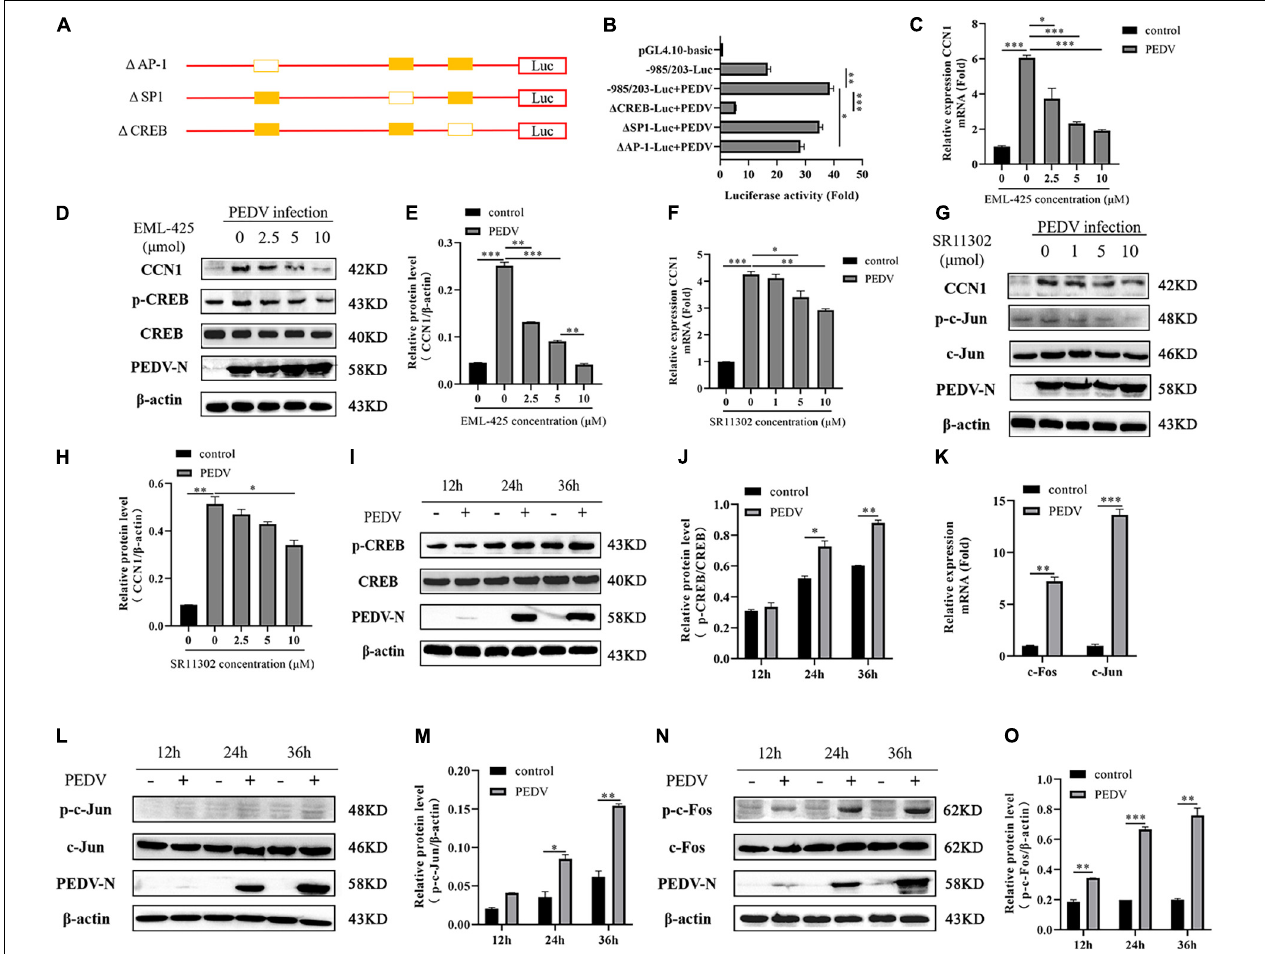
FIGURE 3 | The CREB binding site and AP-1 binding site are indispensable for CCN1 production. (A) Schematic diagram represents the –985/203-luc CCN1 promoter deletion mutant vectors. (B) The –985/203-luc CCN1 promoter and variety of deletion mutant were transfected into Marc-145 cells for 24 h. The cells were infected with PEDV for 48 h determining the luciferase activity. (C,D) Marc-145 cells were treatment using EML-425 (CREB inhibitor) with different concentrations at 1 h and then using PEDV incubated for 48 h. Real-time PCR was used to analyze CCN1 levels (C) , and Western blotting was used to analyze the protein expression of CCN1 (D) . (E) Densitometric analysis of CCN1 relative to β -actin using ImageJ. (F,G) Marc-145 cells were treatment using SR11302 (AP-1 inhibitor) at 1 h and then using PEDV incubated for 48 h. Real-time PCR was used to analyze CCN1 levels (F) , and Western blotting was used to analyze the protein expression of CCN1 (G) . (H) Densitometric analysis of CCN1 relative to β -actin using ImageJ. (I) Marc-145 cells were incubated with PEDV, and cells were collected at 12, 24, and 36 h. Western blotting was used to examine the level of CREB and phospho-CREB. (J) Densitometric analysis of phospho-CREB relative to CREB using ImageJ. (K) Marc-145 cells were infected with PEDV, cells were harvested at 48 h, and the mRNA level of c-Jun and c-Fos were analyzed using real-time PCR. (L) Marc-145 cells were infected with PEDV, and cells were harvested at 12, 24, and 36 h. Western blotting was used to examine the level of c-Jun and phospho-c-Jun. (M) Densitometric analysis of phospho-c-Jun relative to β -actin using ImageJ. (N) Marc-145 cells were infected with PEDV, and cells were harvested at 12, 24, and 36 h. Western blotting was used to examine the level of c-Fos and phospho-c-Fos. (O) Densitometric analysis of phospho-c-Fos relative to β -actin using ImageJ. The data were performed from three independent experiments. The differences were evaluated using Student’s t -test, and significance differences were denoted by ∗ p < 0.05, ∗∗ p < 0.01, ∗∗∗ p <